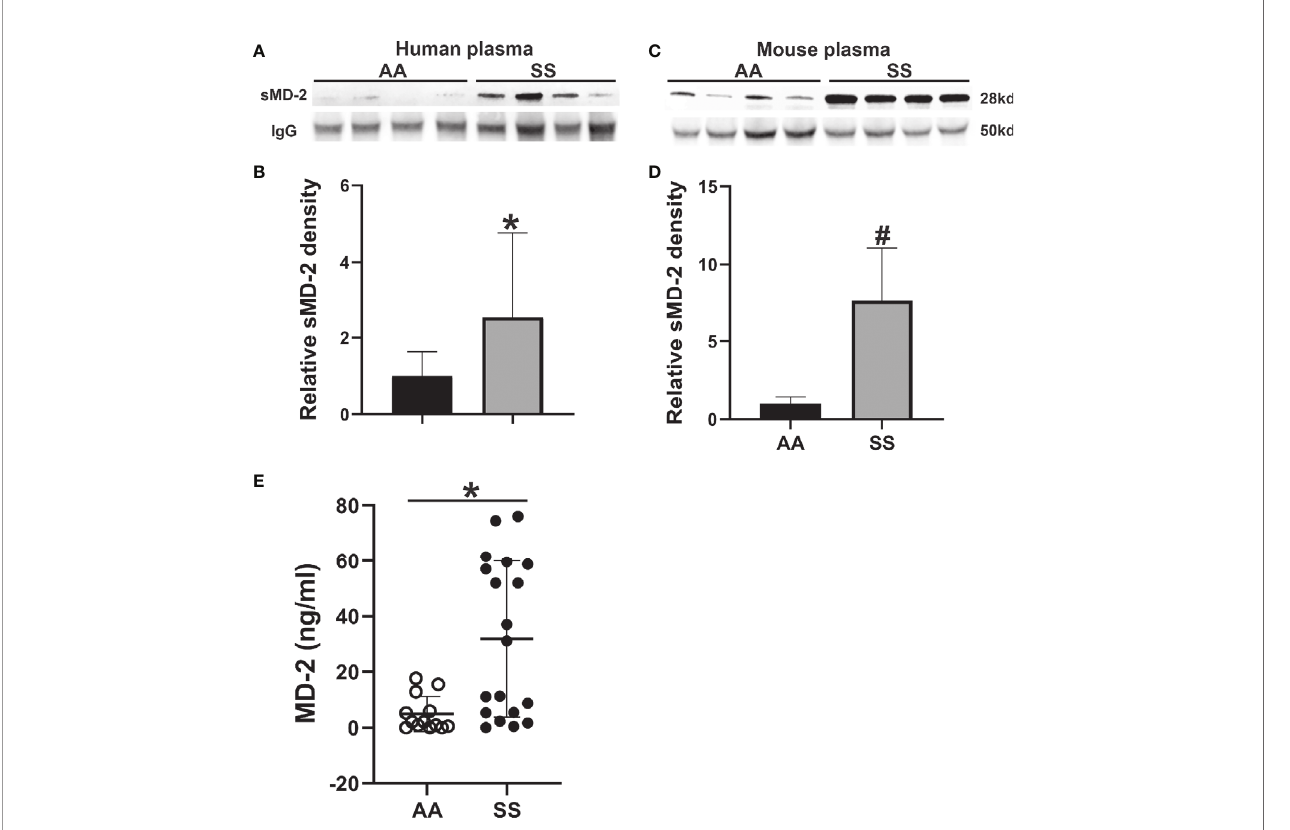
FIGURE 1 | sMD-2 is increased in SCD plasma from humans and mice. (A, C) Representative western blots of sMD-2 from sickle (SS) and normal control (AA) plasma from humans and Townes mice. (B, D) Relative plasma sMD-2 on Western blots is calculated as the density ratios of sMD-2 bands compared to IgG in SS (n=17 for human, n=9 for mice) and AA (n=16 for human, n=7 for mice) plasma. (E) sMD-2 levels in human AA (n=13) and SS (n=19) plasma measured by ELISA. Bars are means ± SD, * p <0.02 and # p <0.002.